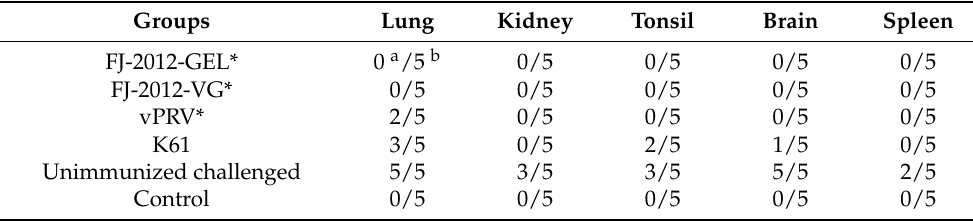
Table 3. The incidence rate of tissue lesions in piglets after challenge with the PRV